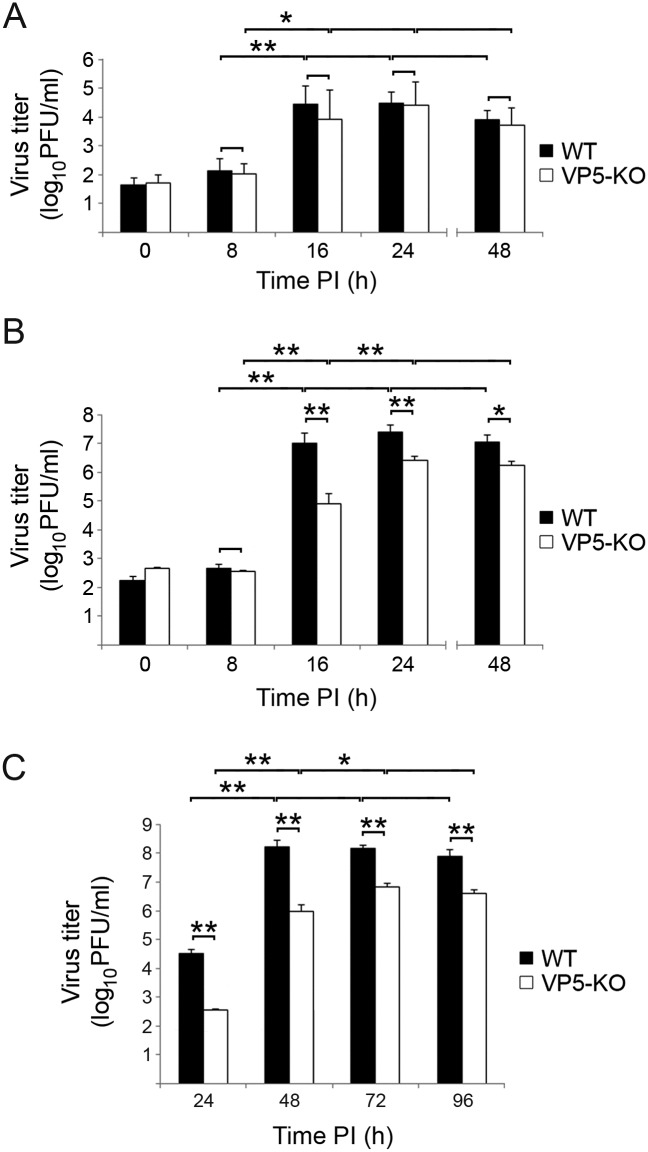
Effect of VP5 expression on virus progeny yields.Comparative time-course analysis of virus progeny yields in QM7 cell cultures infected at high MOI (3 PFU/cell) with the WT or the VP5-KO virus. (A) Intracellular virus titers. (B) Extracellular virus titers. (C) Comparative time-course analysis of total virus progeny yields in QM7 cell cultures infected at low MOI (0.05 PFU/cell) with the WT or the VP5-KO virus. Black and white bars correspond to cultures infected with the WT and the VP5-KO virus, respectively. Presented data correspond to the mean ± the standard deviation of three independent experiments. Virus titrations were carried out in triplicates. Brackets indicate pairwise data comparisons. *p<0.01, **p<0.001 as determined by two-tailed unpaired Student’s t-test.